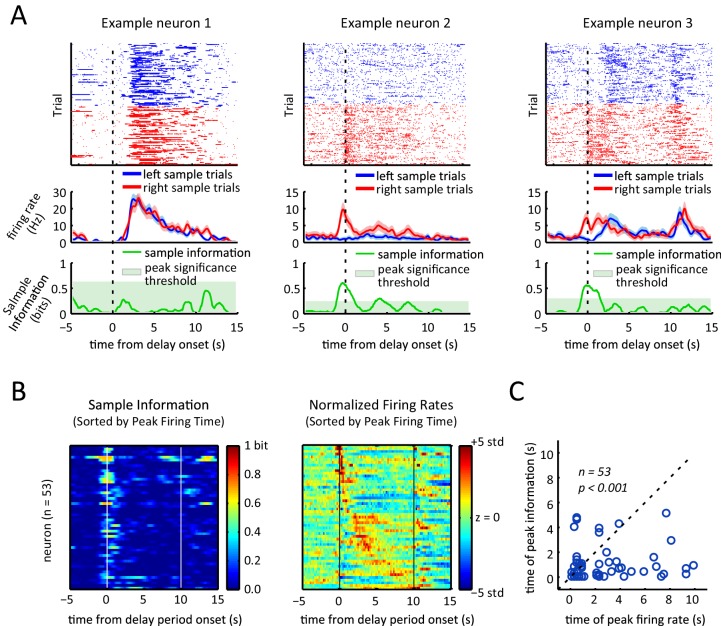
Sample lever information peaks are clustered towards the beginning of the delay period and are not correlated with firing rate peak times.(A) Each column represents data from an example neuron, with neural activity aligned to the onset of the delay period, and activity color-coded in red for right sample trials and left for blue sample trials. Top: raster plot, with each dot representing a spike. Middle: firing rates for left and right sample trials. Shaded area represents ± 1 SEM. Bottom: Information about sample as a function of time. Shaded area represents the 99th percentile of the maximum information expected by chance across the entire time interval, calculated by shuffling the sample labels for the trials. (B) Left: Heat-map of sample information as a function of time for the 53 neurons that had significant information peaks within the 10 s delay period (p<0.01; one-tailed test using shuffled data for null distribution of peak information within the 10 s delay period). Right: Heat-map showing z-scored firing rates of the same neurons depicted in the left plot. Neurons in both the left and right panels are sorted by the peak firing rate in the delay period, such that a neuron on the left plot appears in the same row in the right plot. (C) Time of peak sample information plotted against the time of peak firing rate for 53 sample encoding neurons (where 0 corresponds to the onset of the delay period). The data reveals sample information peaks times occur earlier than firing rate peak times (p<0.001; Wilcoxon signed rank test), and a lack of correlation between the time of peak firing rate and time of peak sample information (r=0.06, p=0.69; Pearson correlation test). All panels are calculated using 10 s-delay correct trials only.